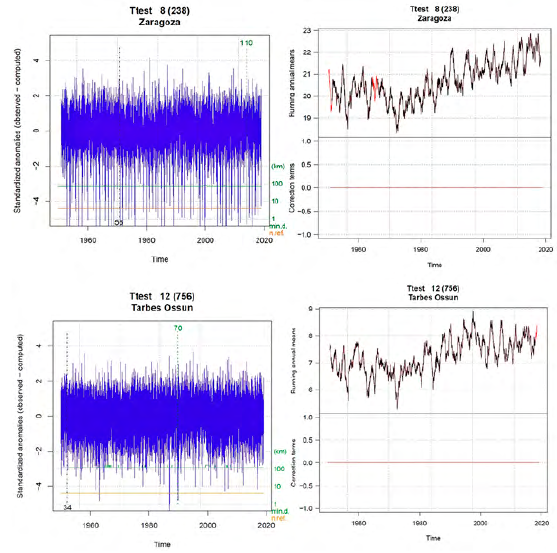
Figure 3. Histograms of SNHT values found in Figure 2. Histograms of SNHT values found in overlapping stepped windows (left), before and after the the complete series (right), before and after the homogenization process. The Zaragoza and Tarbes-Ossun homogenization process. The Tarifa and Ciudad Real meteorological observatories are shown as examples meteorological observatories are shown as examples [click on figure to enlarge] [click on figure to enlarge] Table 4. Statistical summary of the DQC applied by the ClimPACT2.0 software, for the 28 weather stations used, indicating % of NA or percentage of missing data for maximum (TX) and minimum (TN) temperatures, split numbers, global SNHT values, and final percentage original date (POD) after the homogenization